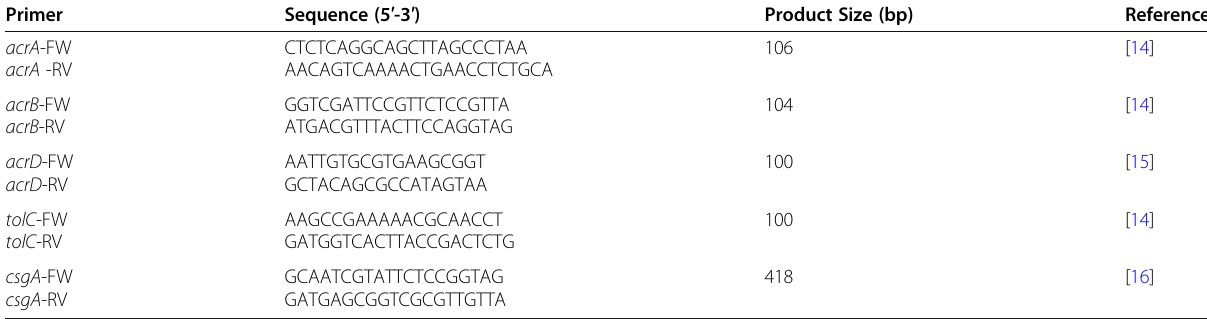
Table 1 List of Primers Used in Targeting Genes Encoding Efflux Pump and Biofilm Forming Ability Primer Sequence (5 ′ -3 ′